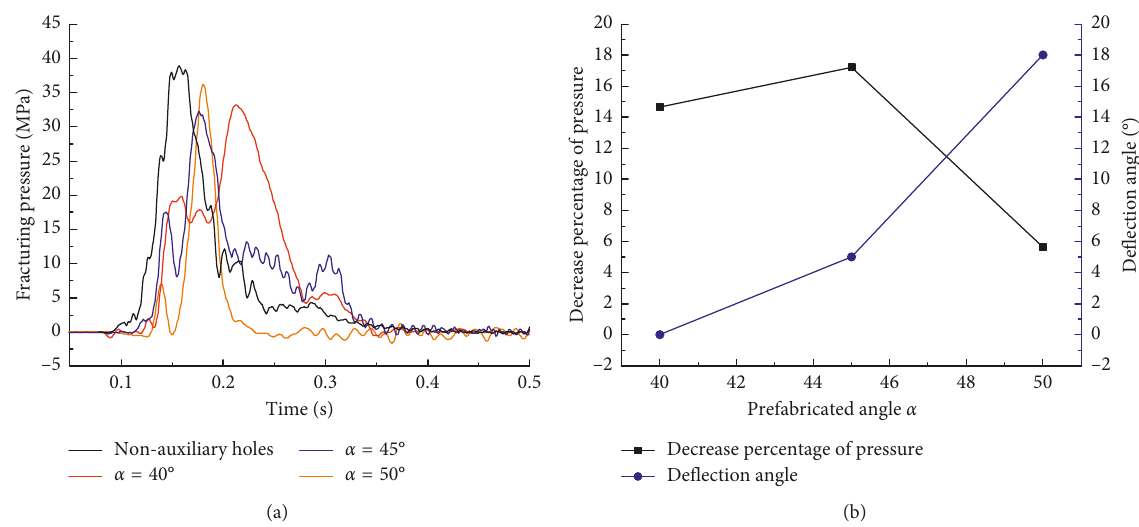
Figure 16: Graphs of data with different prefabricated angles α : (a) variation principle of fracturing pressure with time; (b) decrease percentage of fracturing pressure and deflection angle changed with α